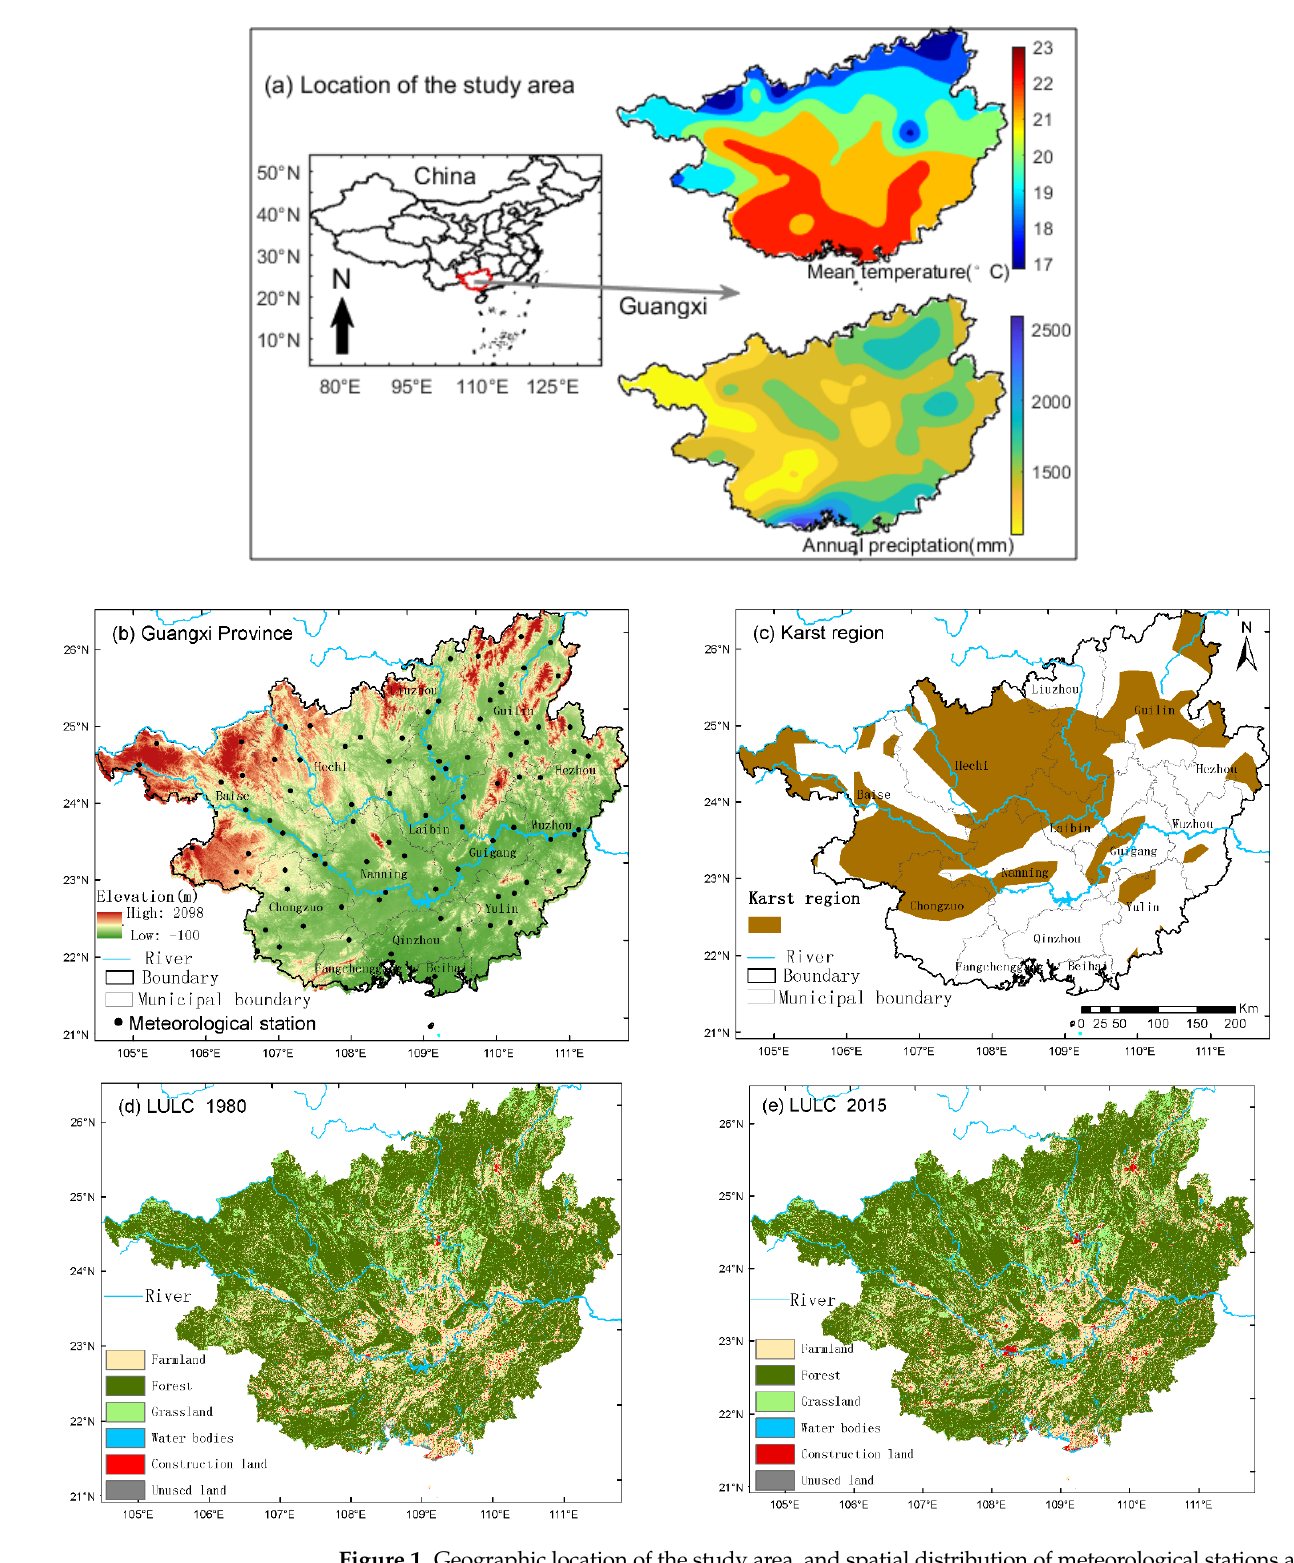
Figure 1. Geographic location of the study area, and spatial distribution of meteorological stations and land use land cover classes (LULC) (for the year 1980 and 2015, respectively). Note: The LULC data and the digital elevation data were provided by the Resource and Environment Science and Data Center, Chinese Academy of Sciences (https://www.resdc.cn/, accessed on 10 October 2021); the karst boundary data were obtained from the World Map of Carbonate Rock Outcrops (http://web.env.auckland.ac.nz/ our-research/karst/, accessed on 14 June